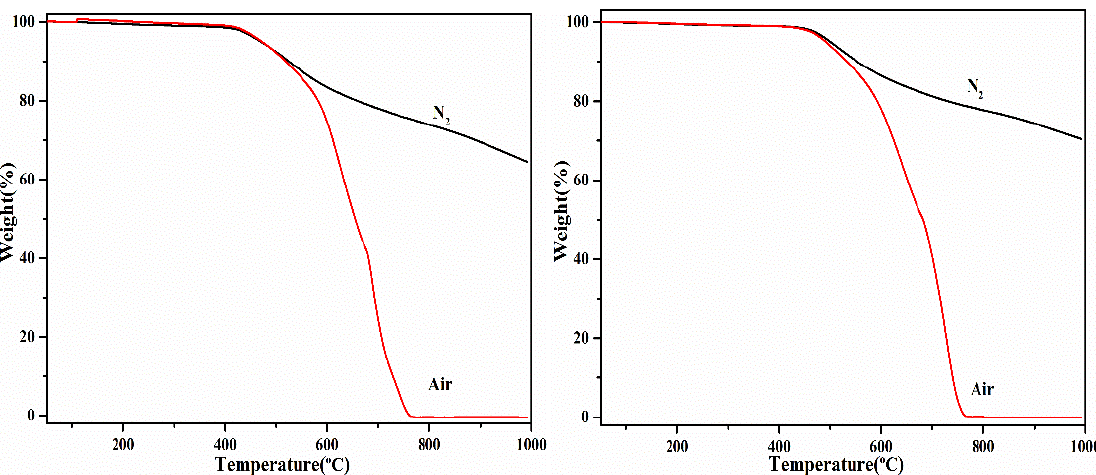
Figure 10. TGA curves of the polymer A ( left ) and polymer B ( right ) under atmosphere of nitrogen and air. Table 3. Thermal performance parameters of the poly(BCPD) resins in nitrogen and air atmosphere.